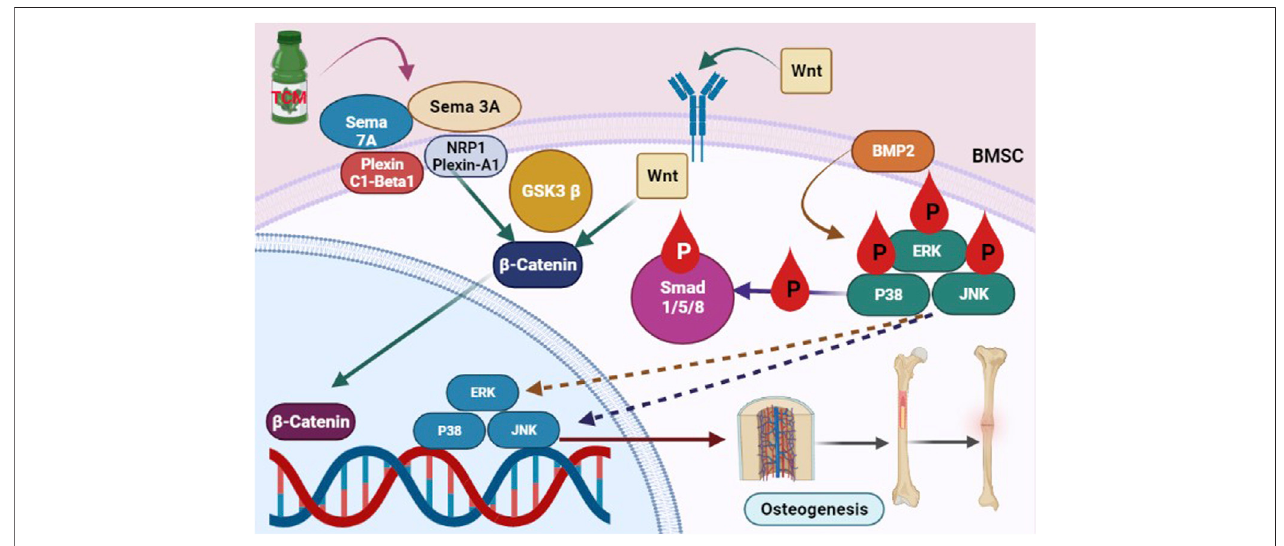
FIGURE 2 | The Signaling pathway involved in TCM induced